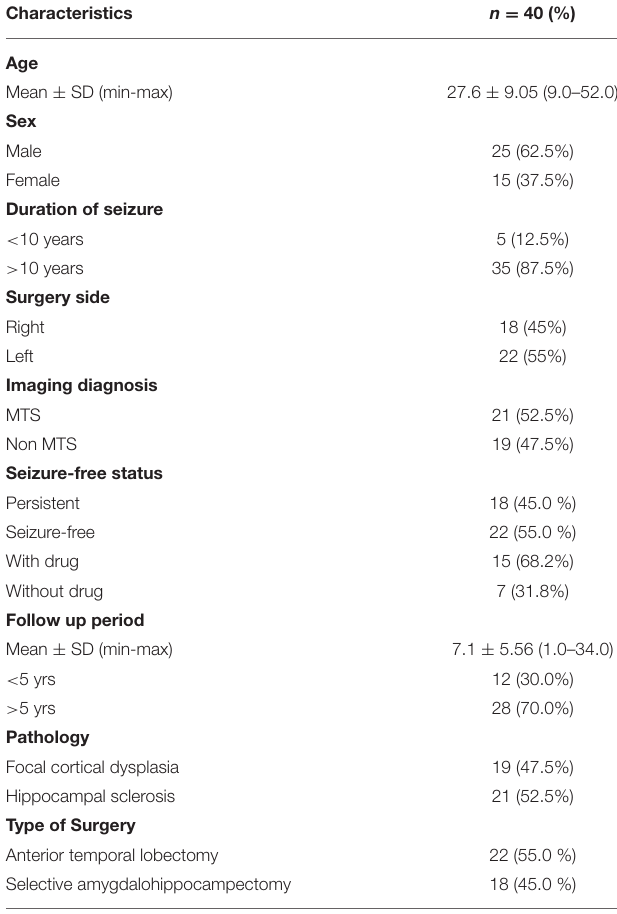
TABLE 1 | Clinical characteristics of the